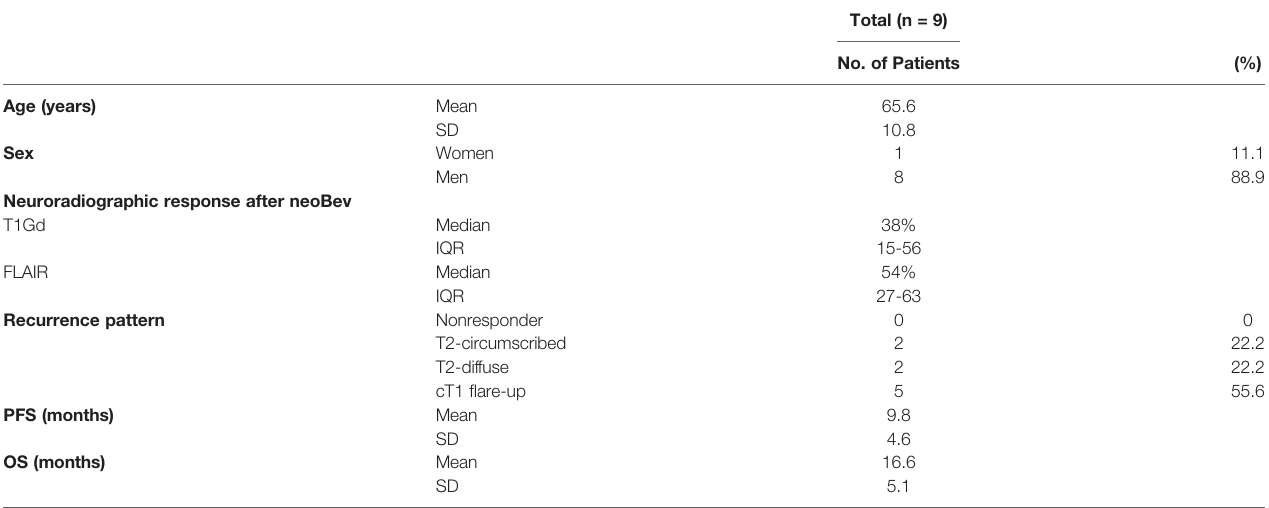
TABLE 1 | Patient